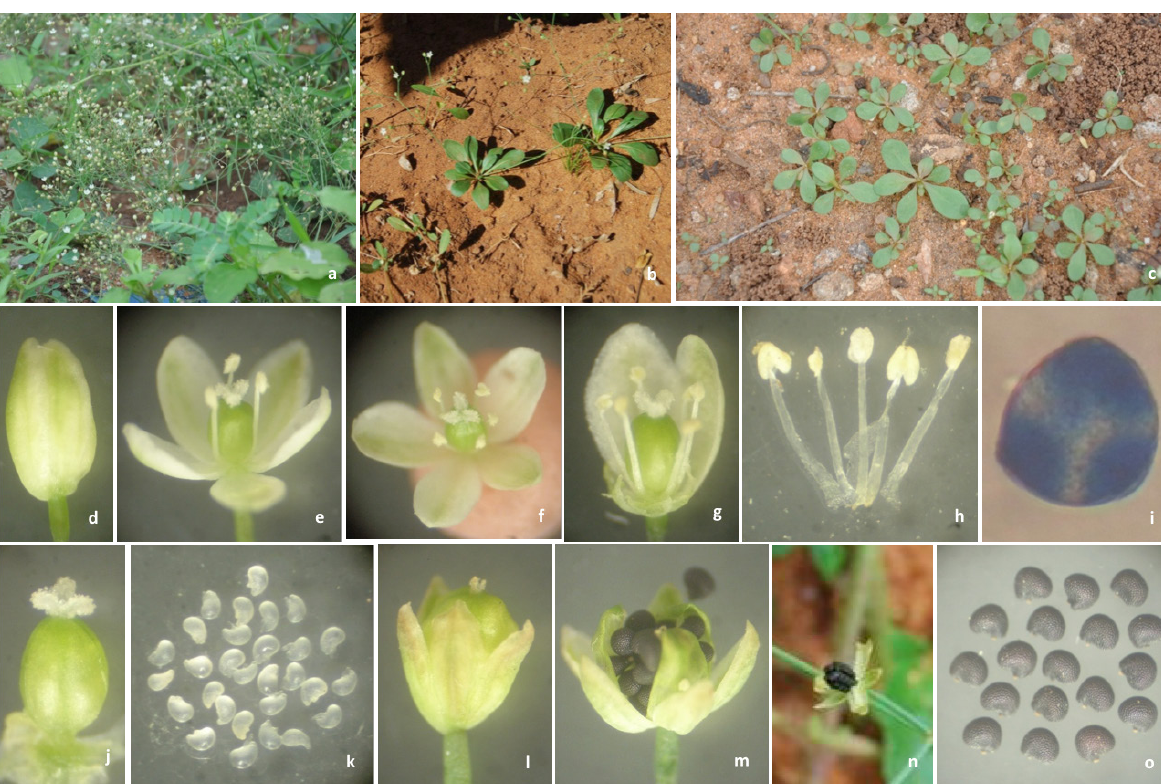
Table 1. Pollen aspects in Mollugo nudicaulis and Mollugo pentaphylla Flower type